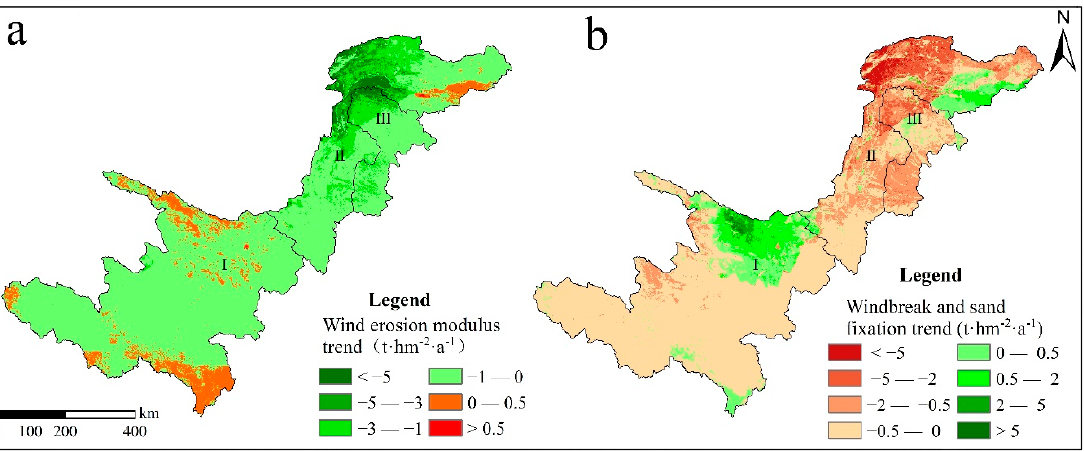
Figure 6. Spatial distributions of the wind erosion modulus ( a ) and windbreak and sand fixation ( b ) change rates in the Upper Yellow River region.